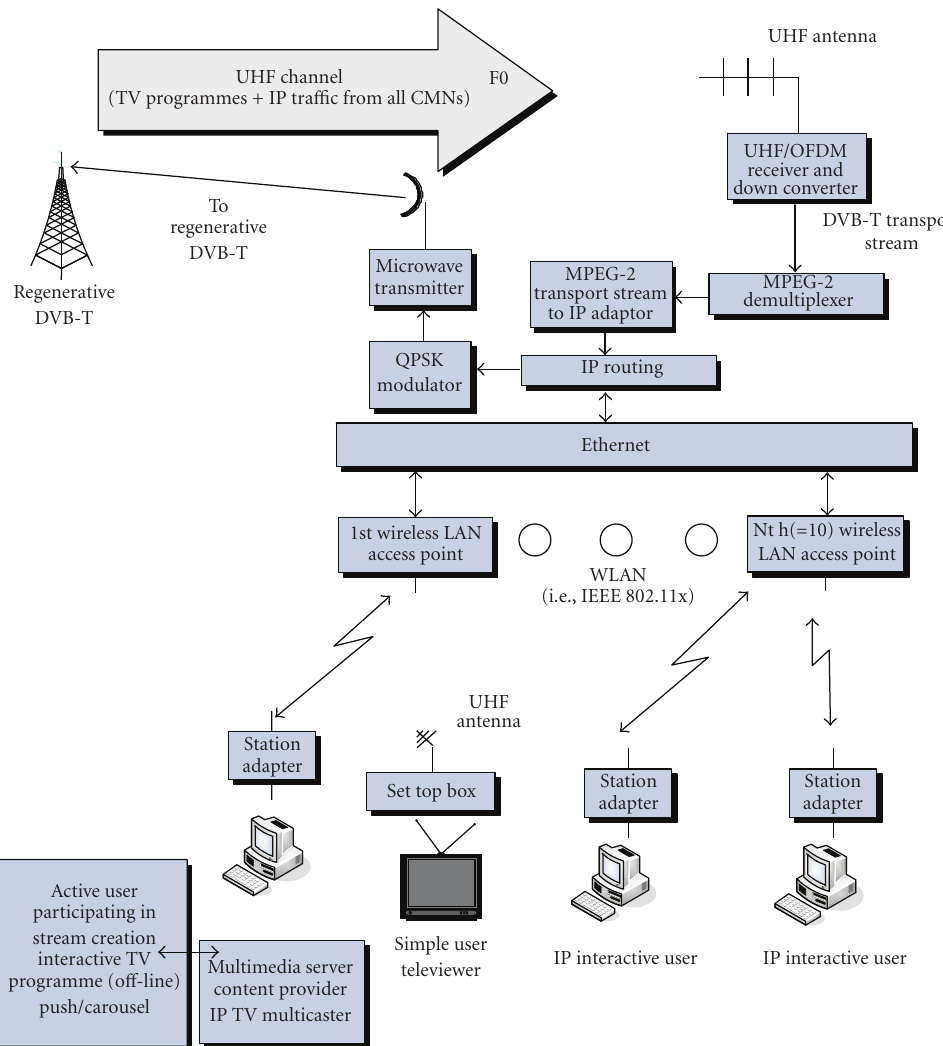
Figure 4: Urban-based